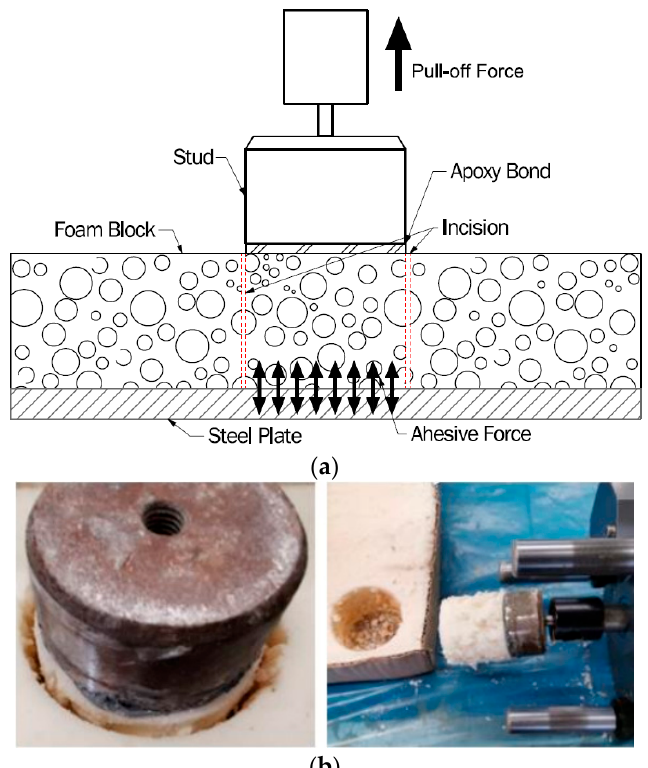
Figure 8. Pull off test; ( a ) test diagram. ( b ) Stud fixed to foam/plate assembly ( left ); foam separated from steel plate ( right ).